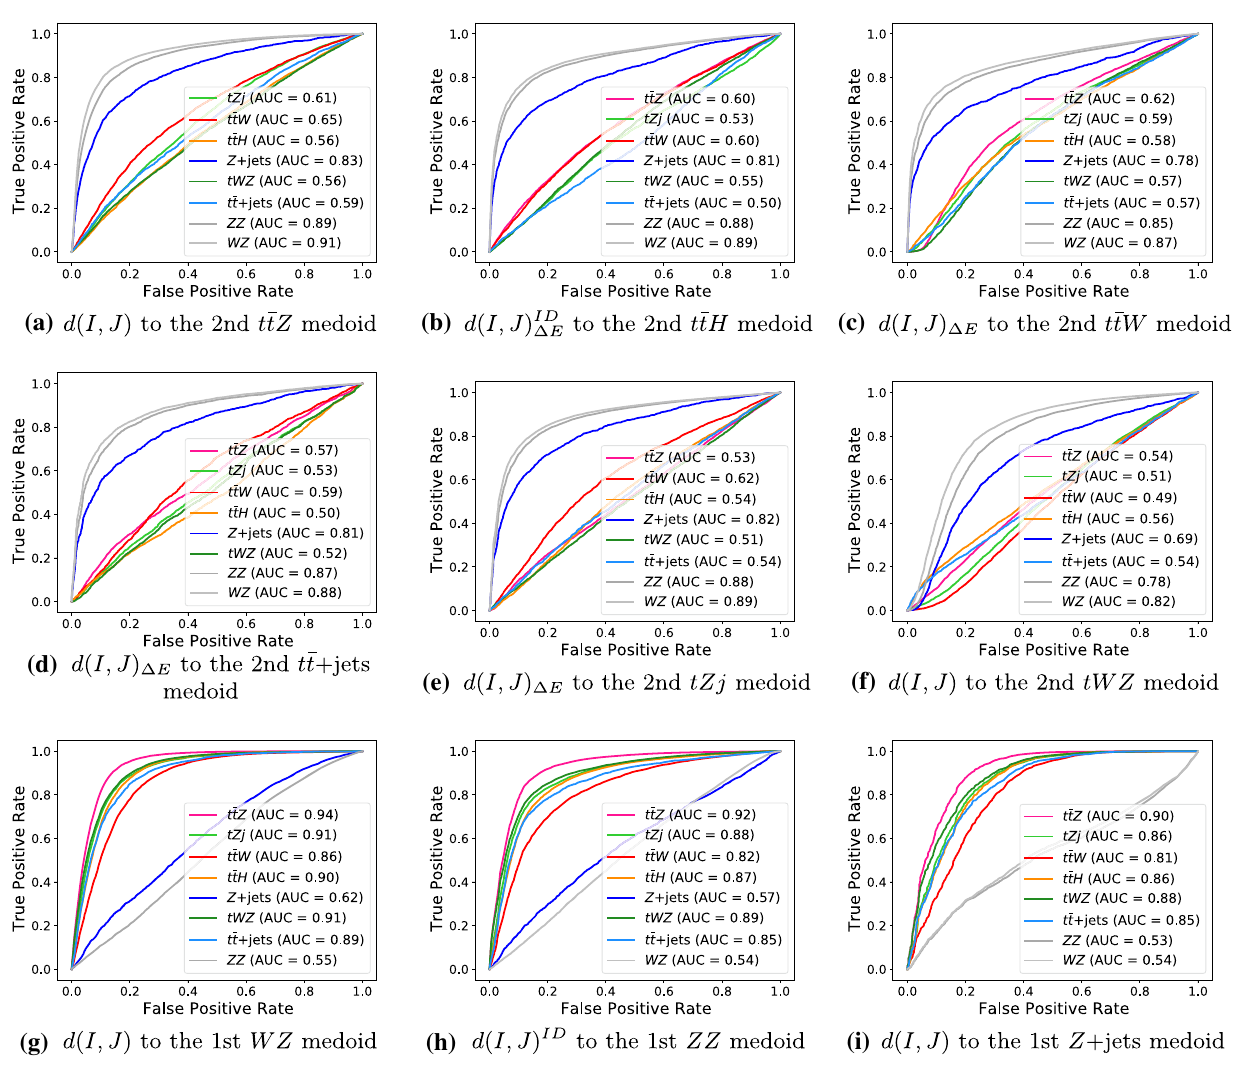
Fig. 4 Illustrative Receiver Operating Characteristic (ROC) curves, corresponding to the Event Distances to a medoid of a t ¯ tZ , b t ¯ tH , c